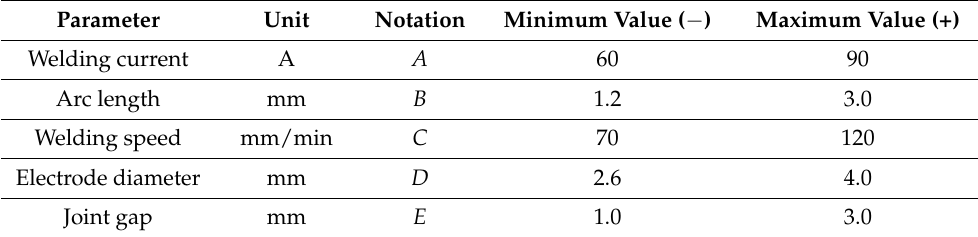
Table 1. Input parameters for SMAW process